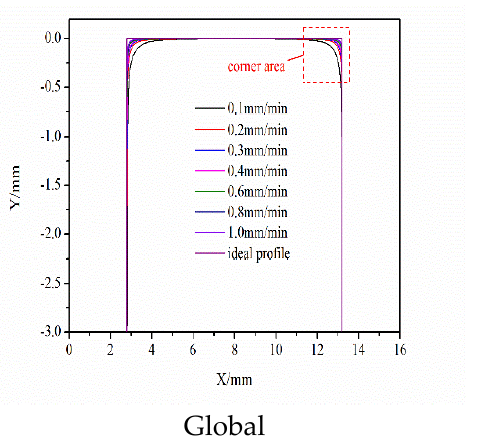
Figure 8. Contours of the workpiece in the conventional method.